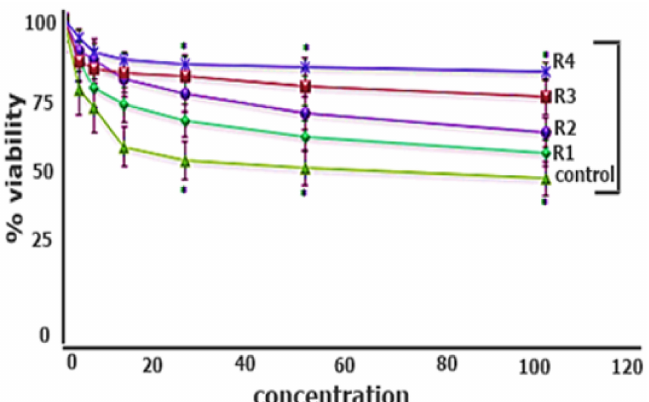
Figure 8. Biocompatibility assay of the mucoadhesive polymeric tablets. The results are listed as mean ± S.D ( n = 3) where the * means a significance level of